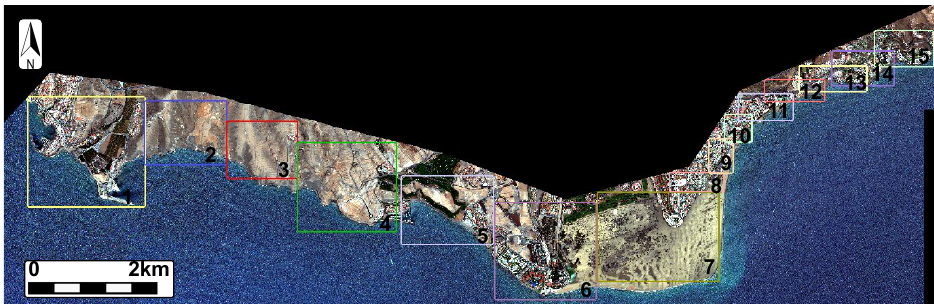
Figure 1. ROIs location projected over the WorldView-2 image of Maspalomas.